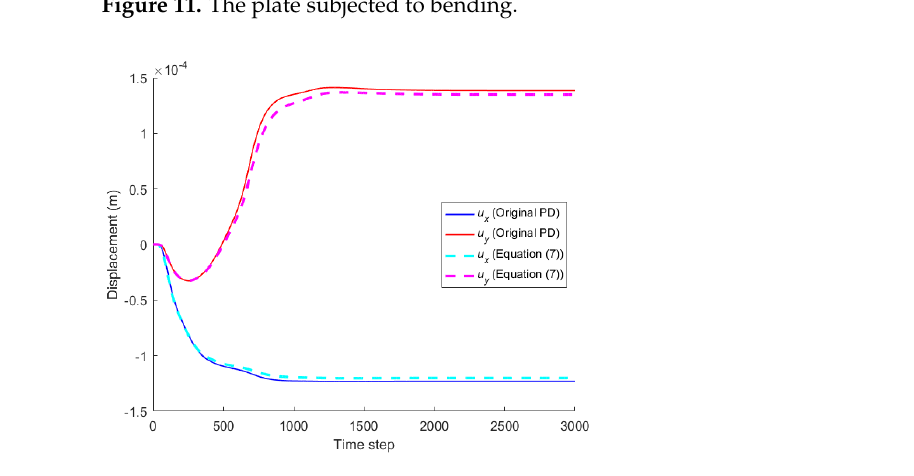
Figure 12. Convergence of displacement at x = − 0.25 m and y = − 0.12 m with time step.